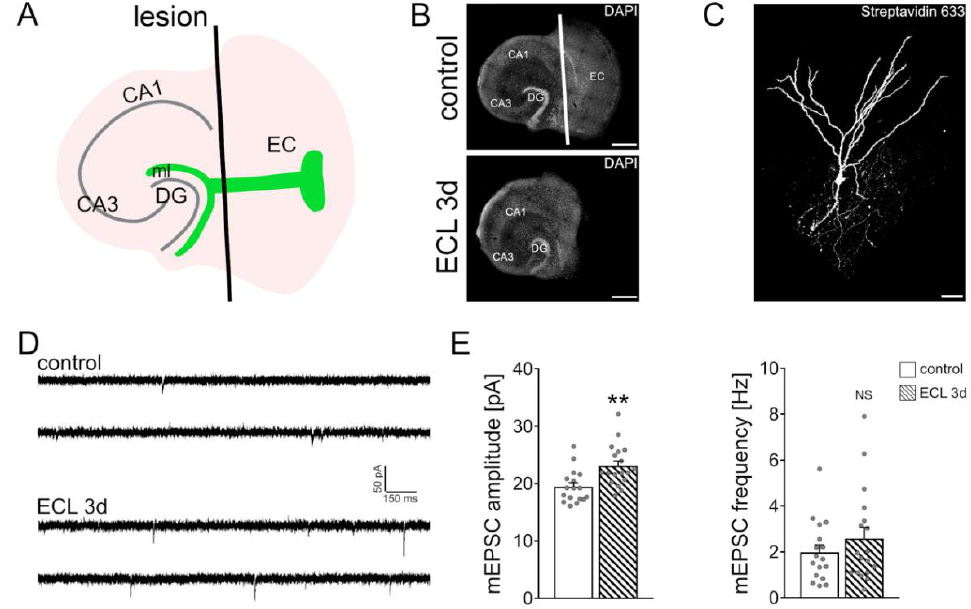
Figure 1. In vitro entorhinal cortex lesion induces a compensatory strengthening of excitatory synapses. ( A ) Schematic illustration of entorhinal cortex lesion (ECL) in vitro (DG, dentate gyrus; CA1, Cornu Ammonis Area 1; CA3, Cornu Ammonis Area 3; ml, molecular layer). ( B ) Mouse organotypic entorhino-hippocampal tissue cultures stained with DAPI (top, non-lesioned control tissue culture; bottom, denervated tissue culture). Scale bars 400 µm. ( C ) Recorded and post-hoc identified dentate granule cell (streptavidin 633; white). Scale bar 30 µm. ( D , E ) Sample traces and group data of AMPA receptor-mediated miniature excitatory postsynaptic currents (mEPSCs) recorded from dentate granule cells of non-denervated controls and age- and time-matched denervated tissue cultures 3 days after the lesion (control, n = 17 cells from 4 cultures; ECL 3d, n = 18 cells from 4 cultures; Mann – Whitney test; ** p < 0.01 NS, non-significant difference). For these graphs and for the rest of the graphs, values represent mean ± standard error of the mean (s.e.m.), and gray dots indicate individual data points.